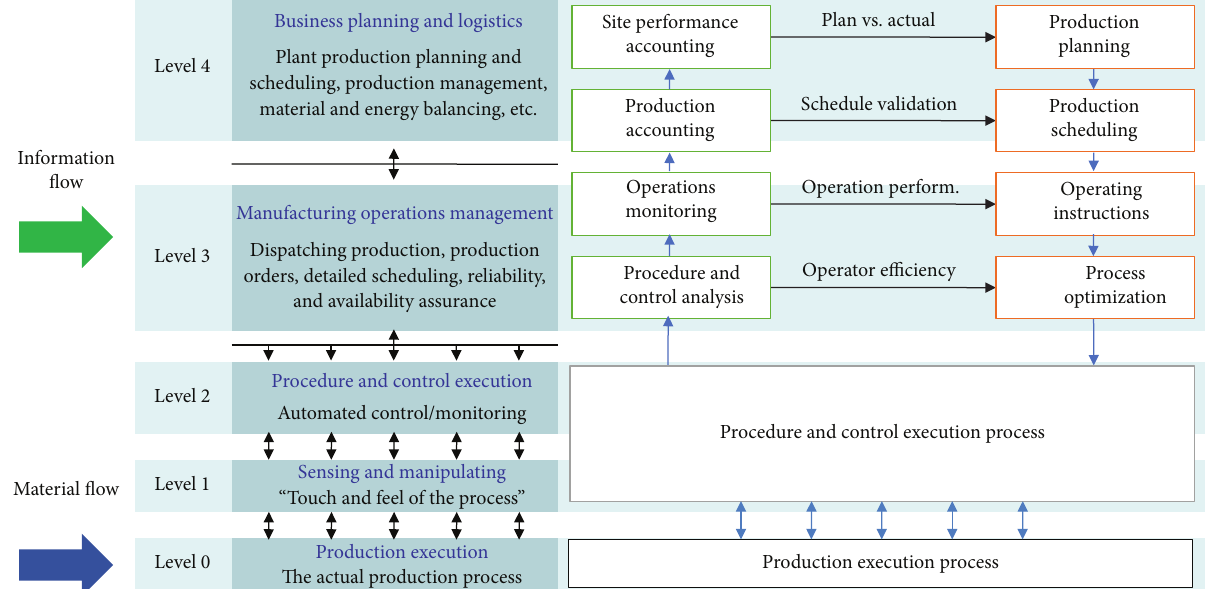
Figure 2: The structure of the ISA-95 standard for constructing vertical integration. It defines 5 levels for the internal hierarchy of manufacturing enterprises. Its purpose is to bridge the highest and lowest stage. A description can be found on the left-hand side of the figure, while optimization and decision-making exercises are also introduced on the right-hand